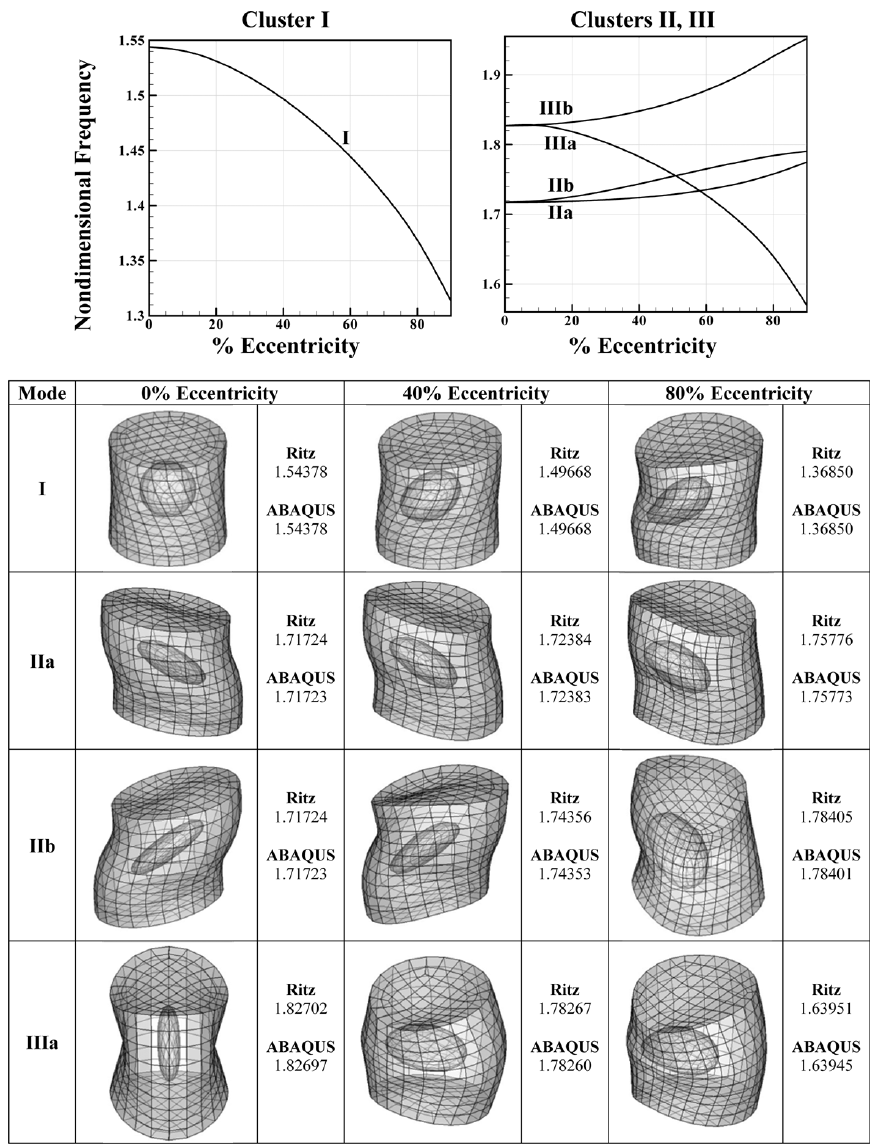
Fig. 2. Variation of the fi rst three frequency clusters with eccentricity parameter for the fi nite cylinder with an internal spherical cavity, along with the fi rst four three-dimensional mode shapes for selected eccentricity parameters. coordinate directions. Nevertheless, in many cases, using unequal numbers of series terms may be more ef fi